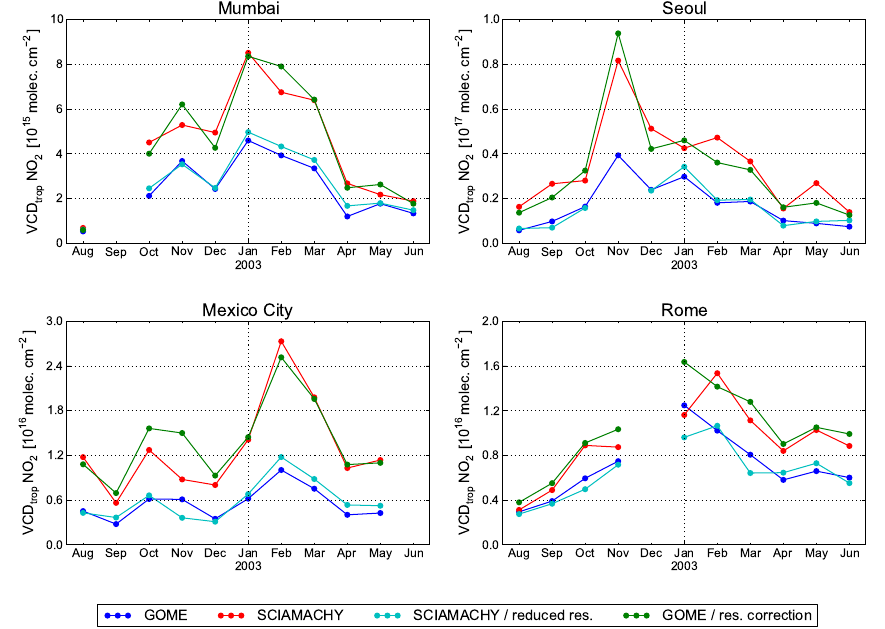
Fig. 8. Monthly averages of VCD trop NO 2 over four exemplary areas showing very good agreement between corrected GOME and original Fig. 8 : Monthly averages of VCD trop NO 2 over four exemplary areas showing very good SCIAMACHY measurements, for the time period August 2002–June 2003. Only those days for which both GOME and SCIAMACHY agreement between corrected GOME and original SCIAMACHY measurements, for the time measurements for a city are available are taken into account. period August 2002 - June 2003. Only those days for which both GOME and SCIAMACHY measurements for a city are available are taken into account.